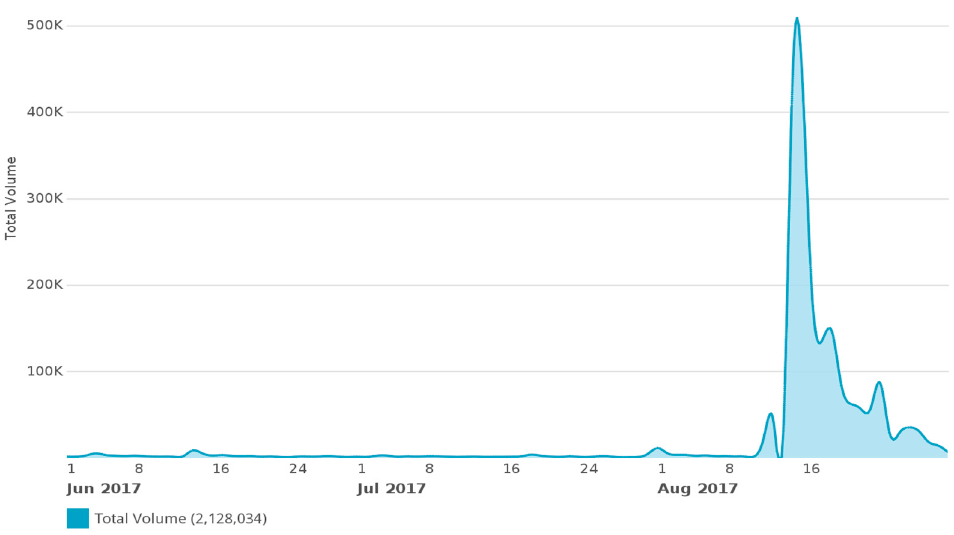
Figure 11. Tweets mentioning ‘alt-left’ before and after the August 15 press conference.